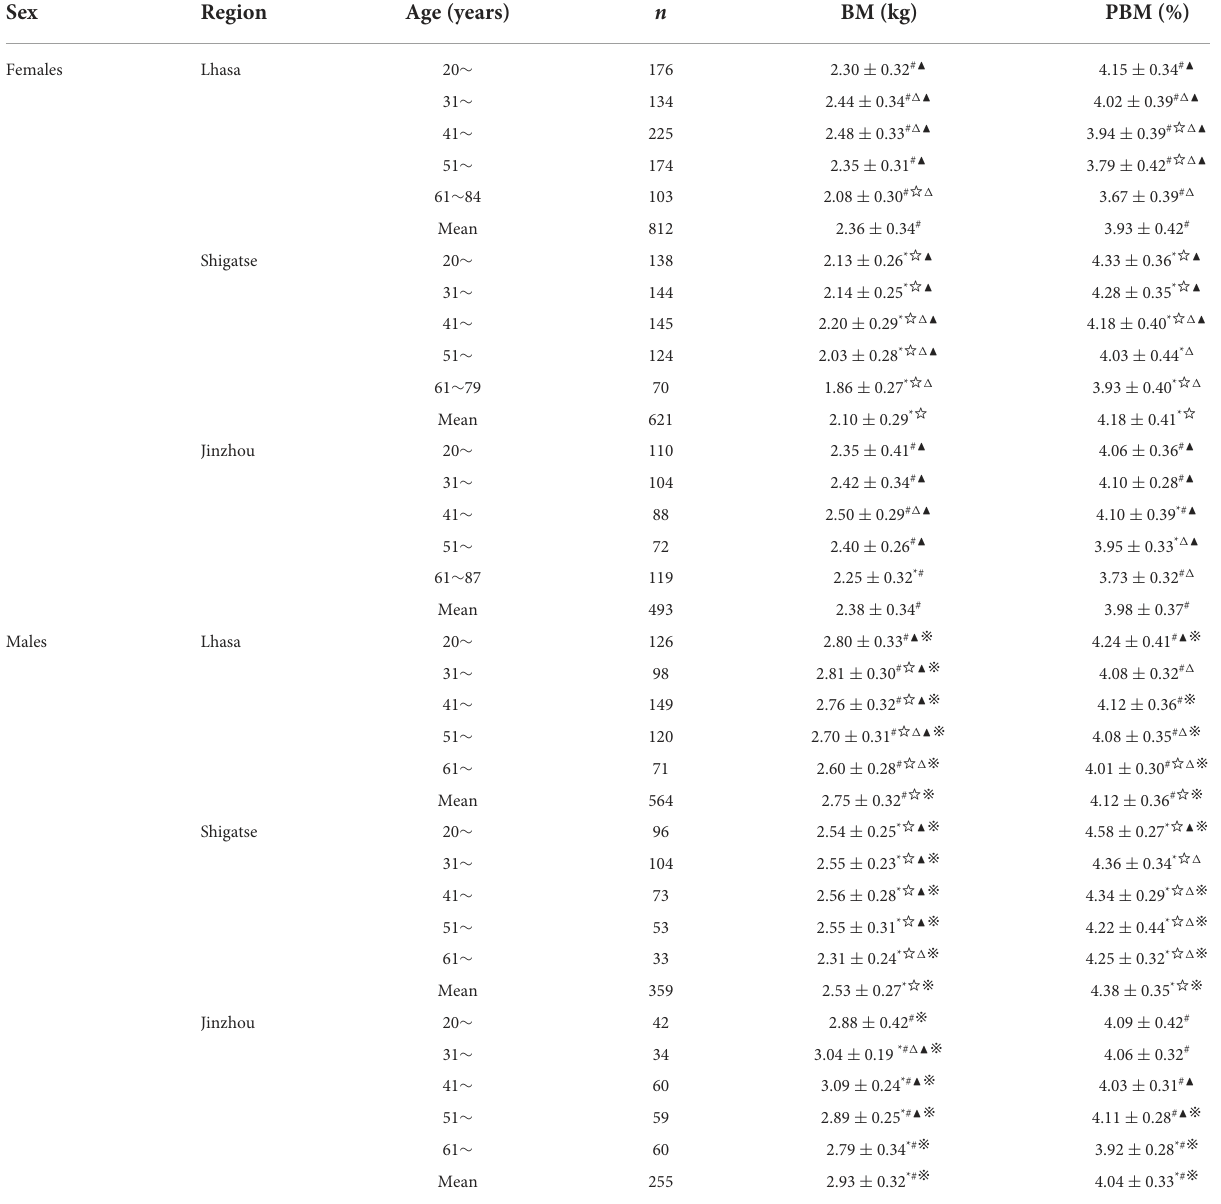
Data are presented as the means ± SDs. Compared with Lhasa for the same age and sex, * P < 0.05; compared with Shigatse for the same age and sex, # P < 0.05; compared with Jinzhou for the same age and sex, ☆ P < 0.05; compared with the 20 ∼ age group for the same altitude and sex, 1 P < 0.05; compared with the 60 ∼ age group for the same altitude and sex, N P < 0.05;comparedwithfemalesforthesamealtitudeandage, ※ P < 0.05.